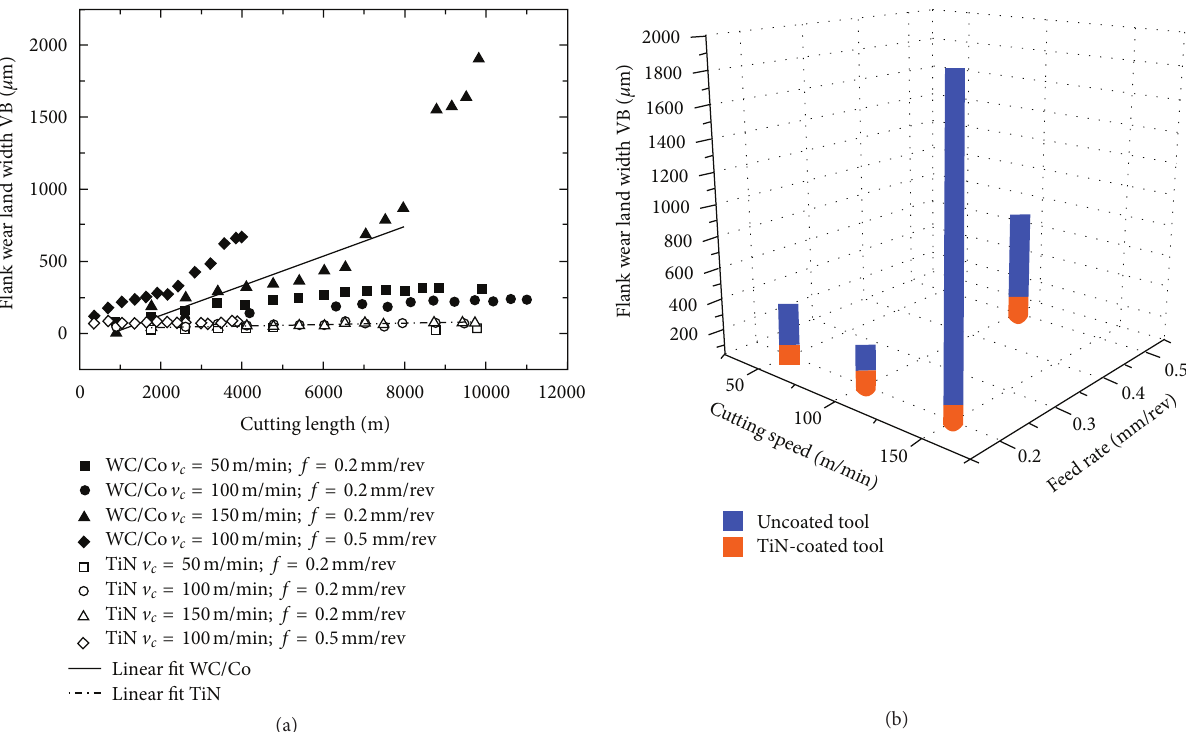
Figure 5: Comparison of flank wear land width VB with respect to the cutting length for the uncoated (black closed symbols) and TiN-coated (open symbols) cutting tool. The diagram on the right side shows a comparison (uncoated versus coated cutting tool) of the flank wear land width VB in the final state of the cutting tool with respect to cutting speed and feed rate.